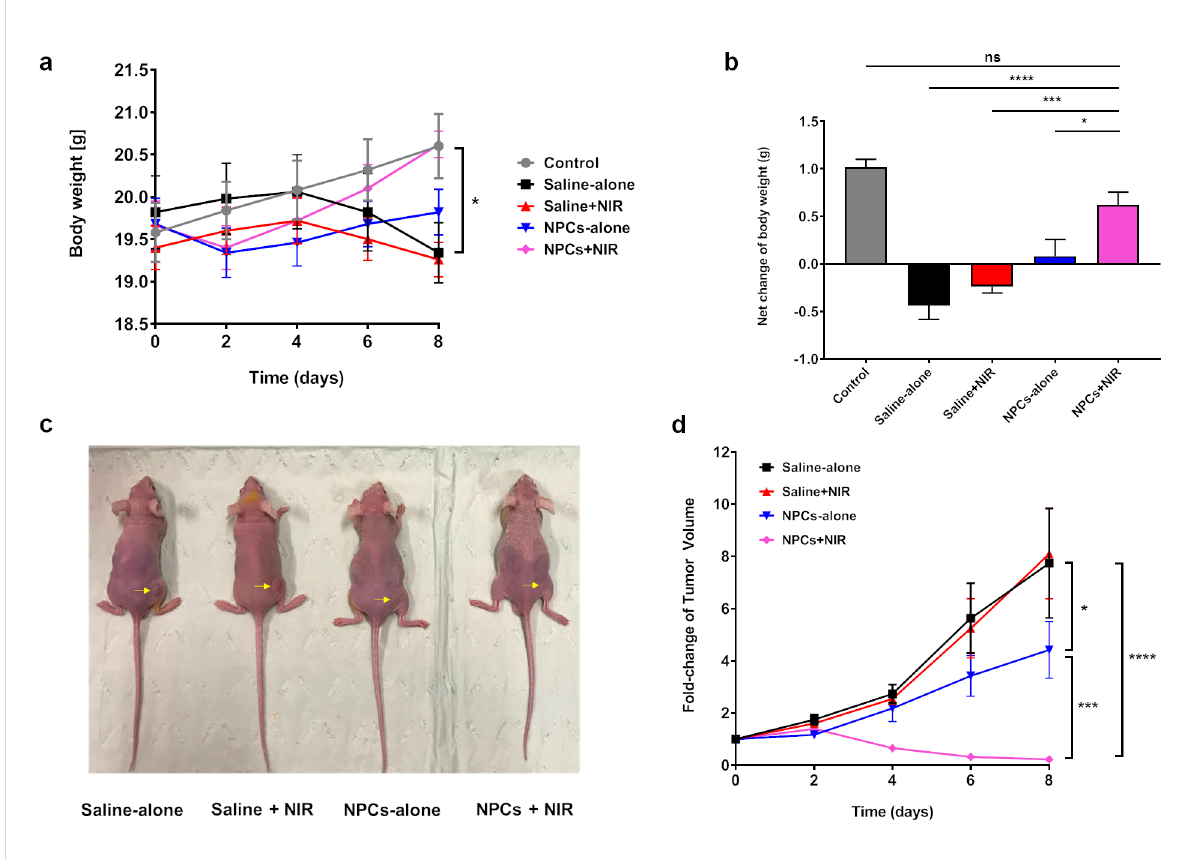
Figure 4: In vivo photothermal therapy in BALB/c mice bearing tumor xenografts. (a) Changes of body weight over the 8-day period post PTT. * p < 0.05, control vs NPCs + NIR at day-8, calculated by two-way repeated measures ANOVA adjusted by Tukey’s multiple comparisons, n = 8. (b) Net body weight changes by the end of the study (day 8 versus day 0), * p < 0.05, *** p < 0.001, **** p < 0.0001 calculated by one-way ANOVA adjusted by Dunnett’s multiple comparisons, n = 8. (c) Representative photographs of tumor-bearing mice in each treatment group by the end of the study. Yellow arrows indicate tumor location. (d) Growth curves of tumors in each treatment group. Tumor size was first normalized to its initial size (day-0), then expressed as fold-change over the latter. * p < 0.05, saline-alone vs NPC-alone; *** p < 0.001, NPC-alone vs NPCs + NIR; **** p < 0.0001, saline-alone vs NPCs + NIR; two-way repeated measures ANOVA adjusted by Tukey’s multiple comparisons, n =